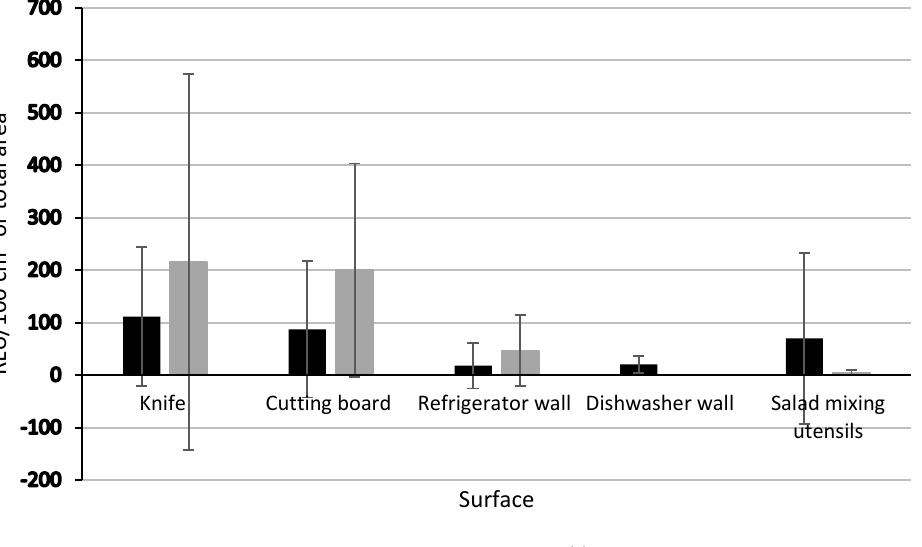
Figure 1. Average RLU values of the kitchen surfaces referring to older and younger consumers, measured via ATP bioluminescence ( n = 16). Note: The measurements of dishwasher walls referring to older consumers were not included because most of them did not have this appliance.